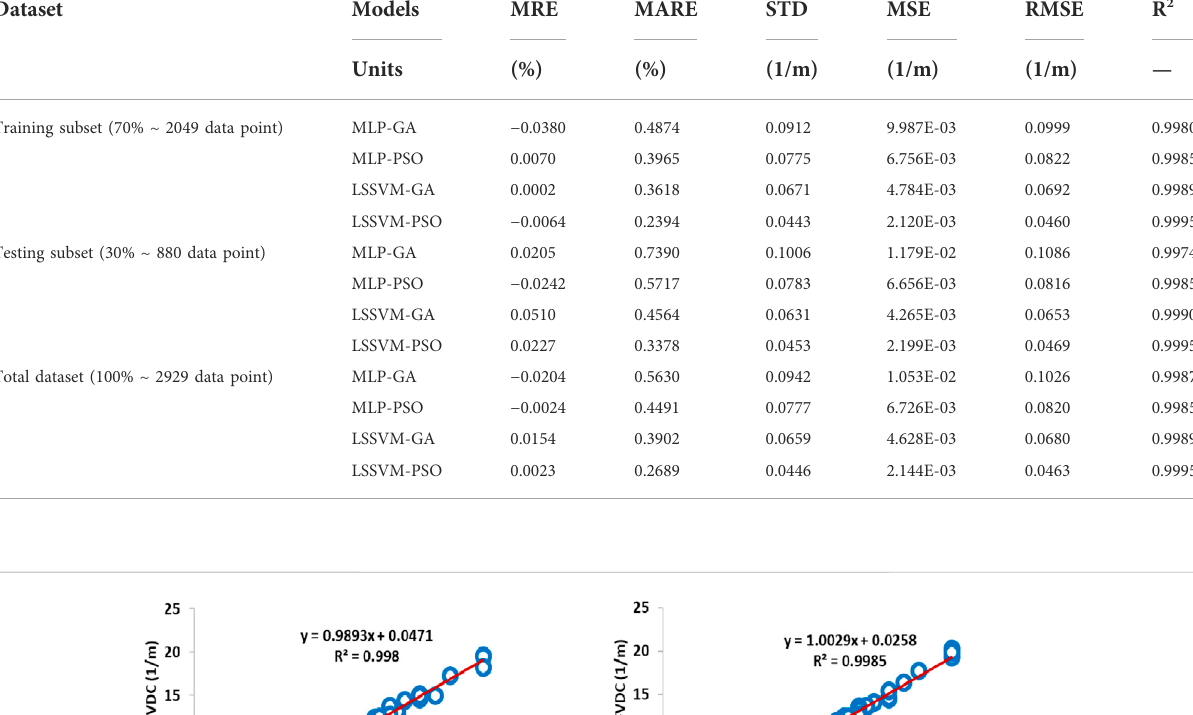
TABLE7PredictionofFVDCpredictionperformancefortraining,testingandtotaldatasetbasedonfourrobusthybridmachinelearningLSSVM-PSO, LSSVM-GA, MLP-PSO and MLP-GA based on dataset of well #W1.